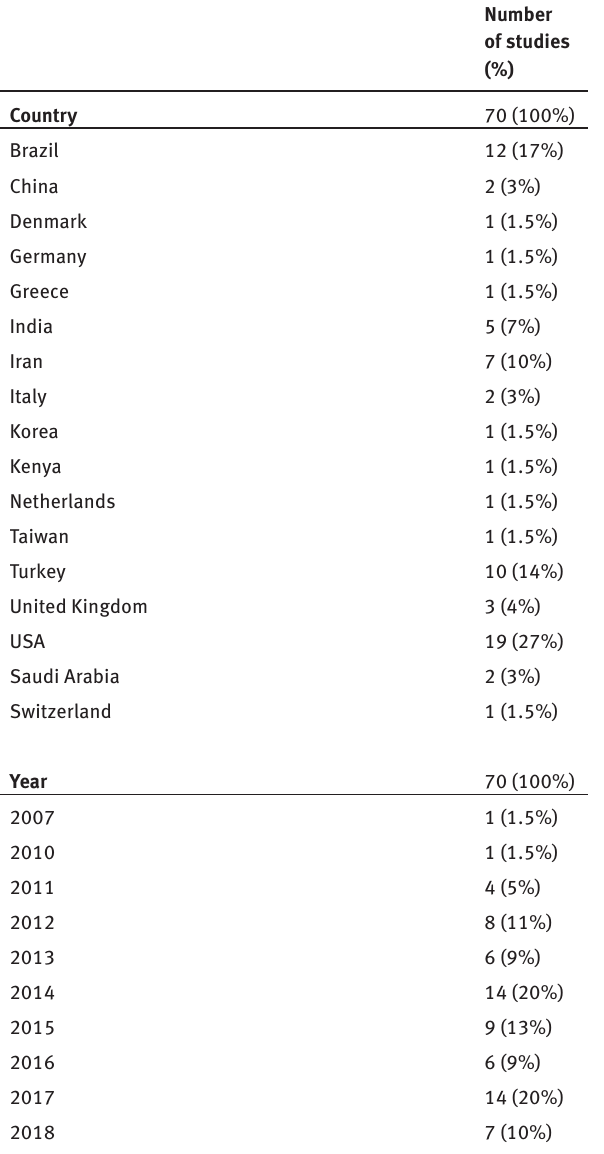
Table 2 continued: Description of the retrospective studies